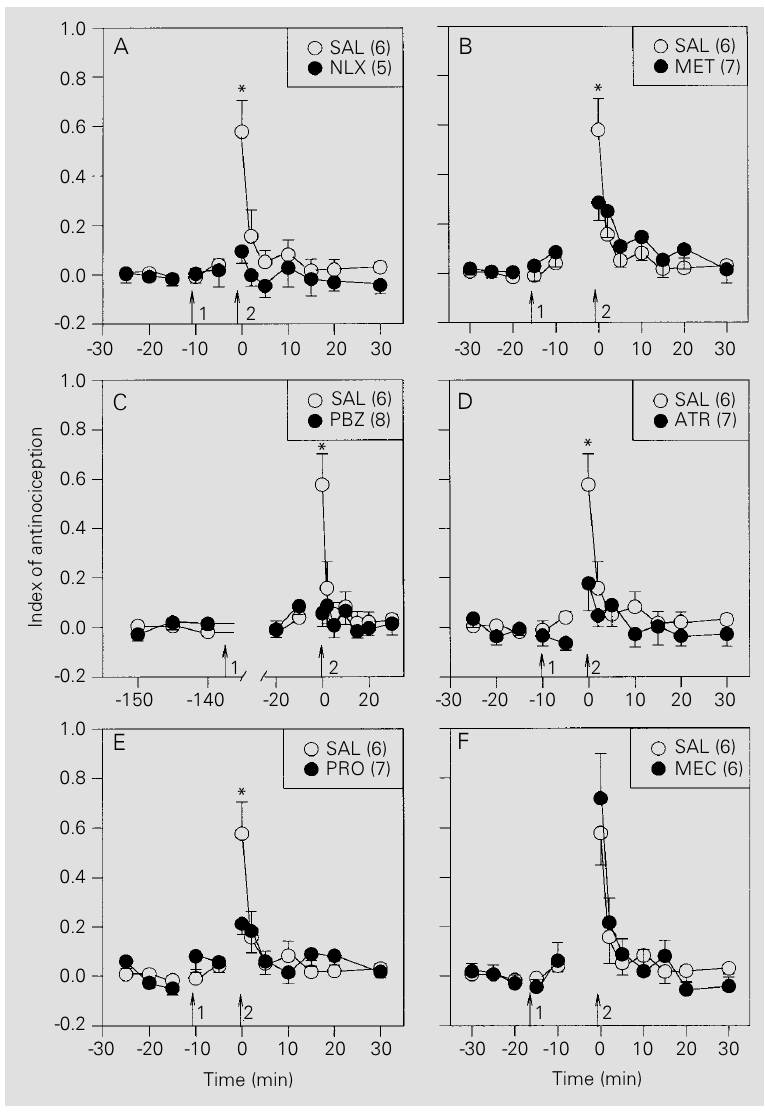
Figure 2 - Effects of intraperitoneal administration (arrow 1) of saline (SAL; 0.1 ml/kg) or antagonists (1 mg/kg) on the antinociception induced by electrical stimulation (arrow 2) of the medial nucleus of the amygdala of rats. A , Effect of naloxone (NLX); B , effect of methysergide (MET); C , effect of phenoxybenzamine (PBZ); D , effect of atropine (ATR); E , effect of propranolol (PRO); F , effect of mecamylamine (MEC). The number of rats per curve is given in parentheses. Data are reported as mean – SEM for each group of rats. *P<0.05 compared to drug-treated animals (Duncan